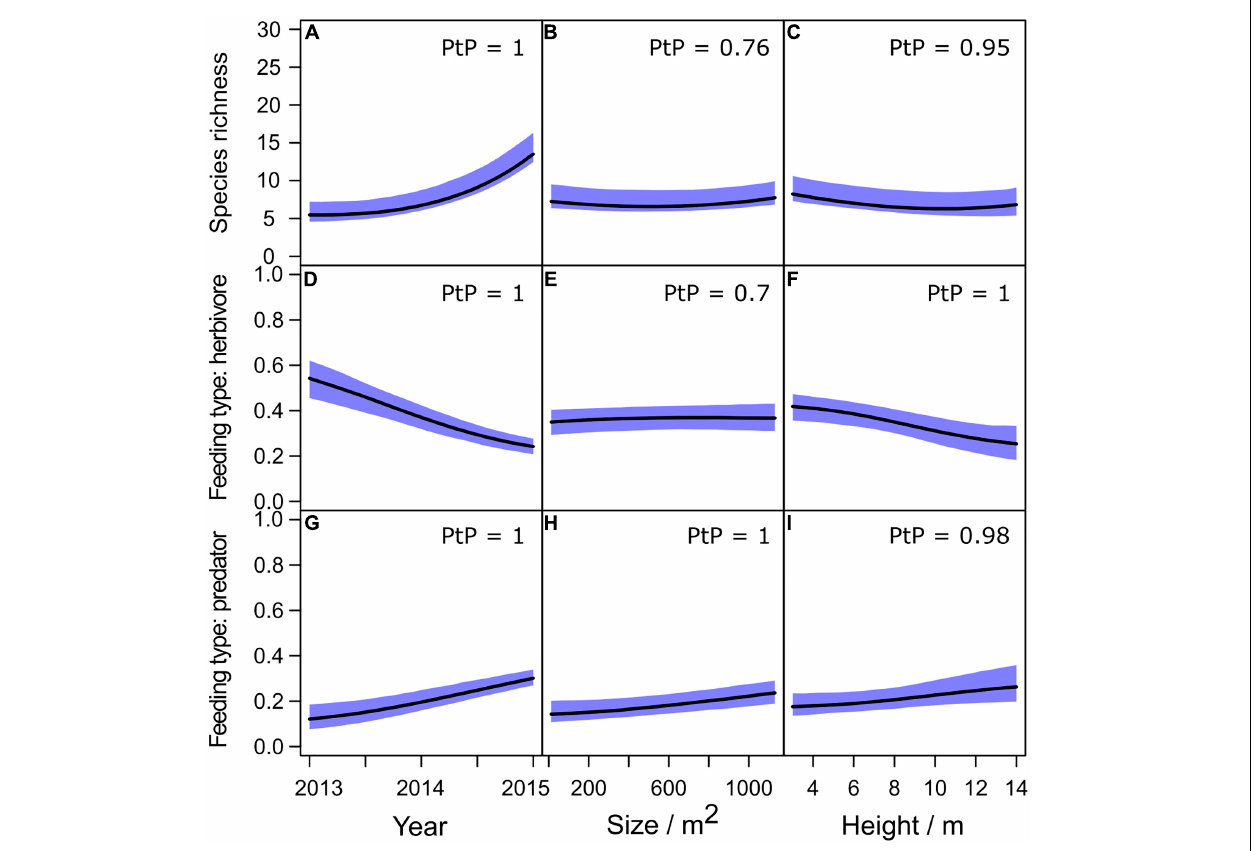
FIGURE 5 | Predictions from the roof model showing patterns in expected species richness (A–C) and fractions of juvenile feeding types (D–I) with time (first column), roof size (second column) and roof height (third column). We set the sampling period to late summer and used the mean value of the logarithm of read count in all predictions. Confidence intervals for the predictions are plotted as colored areas. PtP = Posterior probability. The values are for prediction scenarios differing at the minimum and maximum covariate